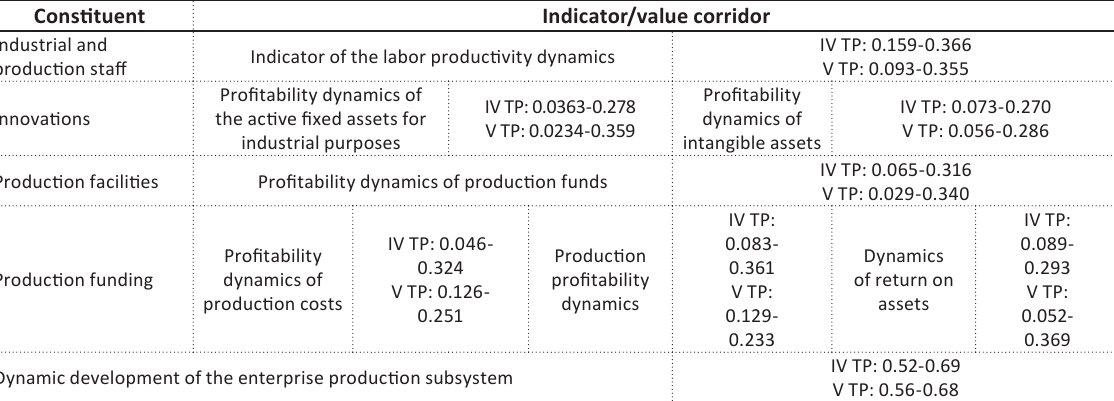
Table 1. Target values of the enterprise production subsystem development to form an effective project portfolio